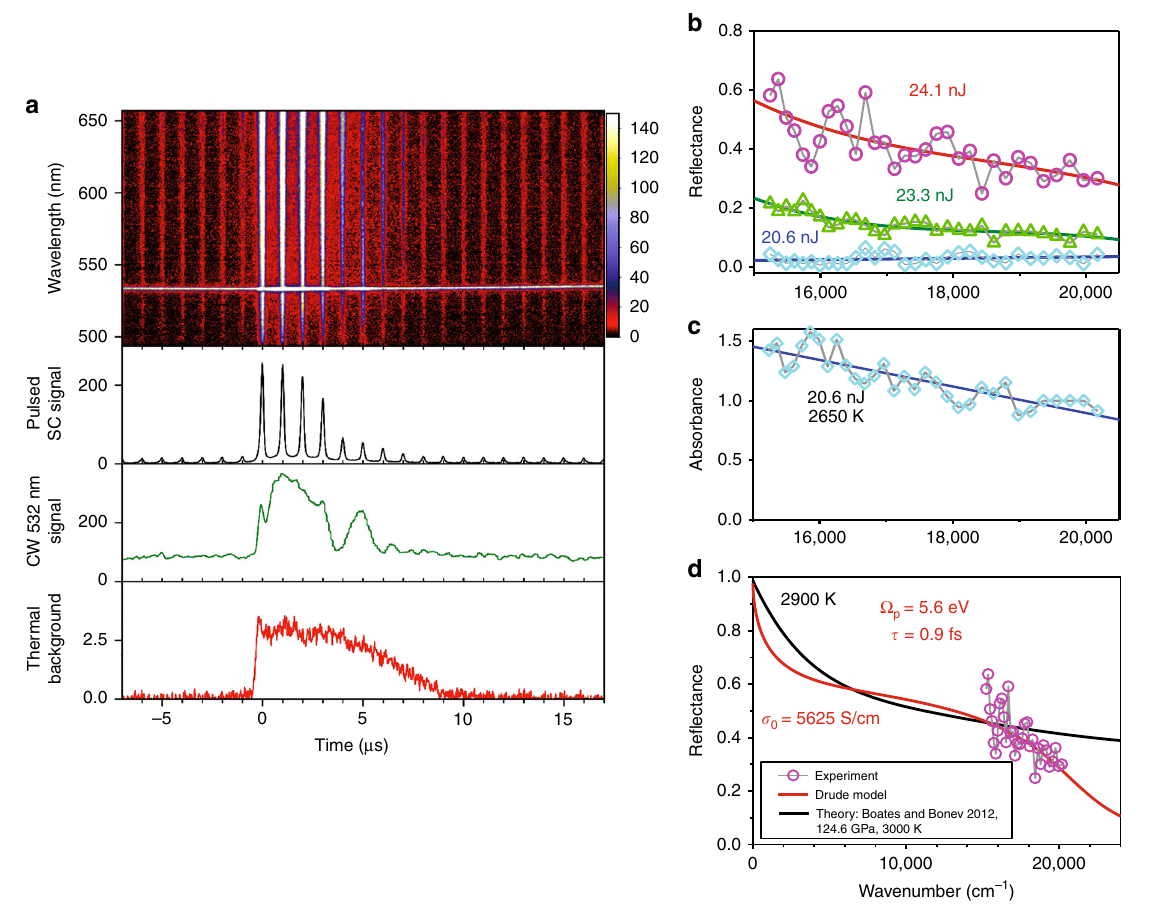
Fig. 3 Optical transmission and re fl ectance measurements of nitrogen at 128 GPa through the transformation to a conducting state. a Upper panel: Spectrogram of transient re fl ectivity, which increases drastically in the heated state and returns to its initial state after the ninth μ s. Bottom three panels: wavelength-integrated SC pulsed and 532 nm continuous probes and thermal radiation intensities as a function of time, respectively. b Transient re fl ectance spectra as a function of the laser energy picturing the transition into the high re fl ectance state; the spectra are normalized to the reference spectra of the diamond – N 2 interface obtained without heating and determined using the refractive indices of diamond and compressed cold N 2 and the transmission of the hot N 2 layer (Methods section and Supplementary Figs. 5, 6). c Transient absorption spectra corresponding to the lowest energy re fl ectance spectrum of b and used to normalize the re fl ectance spectra of b (Supplementary Fig. 6). d An example of the re fl ectance spectrum along with a Drude fi t (Methods section), and theoretical calculations of ref. 35 for polymeric conducting fl uid yielding the DC conductivity of σ 0 ≈ 3000